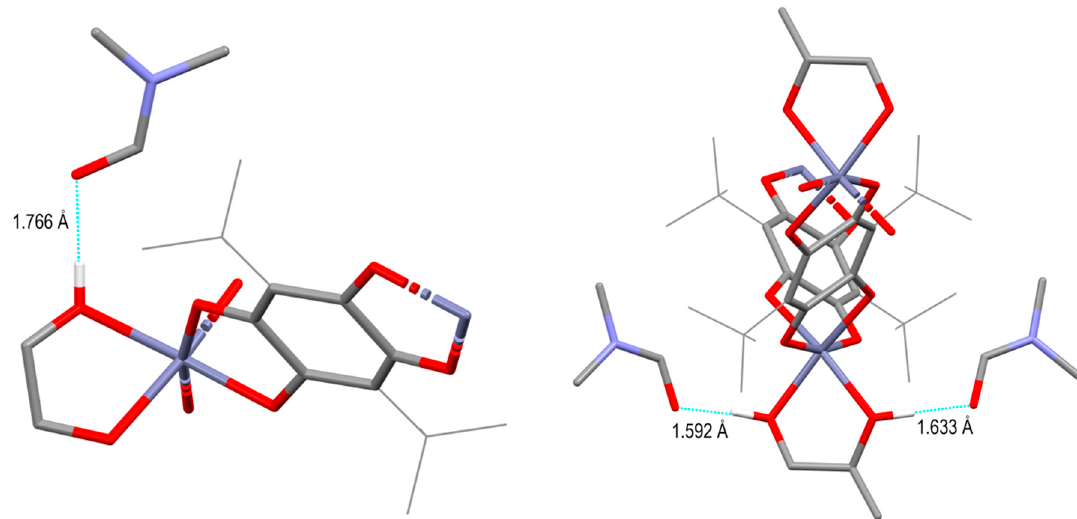
Figure 6. The view of pores in crystals of 1 ( left ) and 2 ( right ) along the (010) vector. The pore vol- umes were evaluated using probe radius 1.2 Å and approx. grid spacing 0.7 Å. Color code: the outer side of the pores is yellow; the inner side is blue.